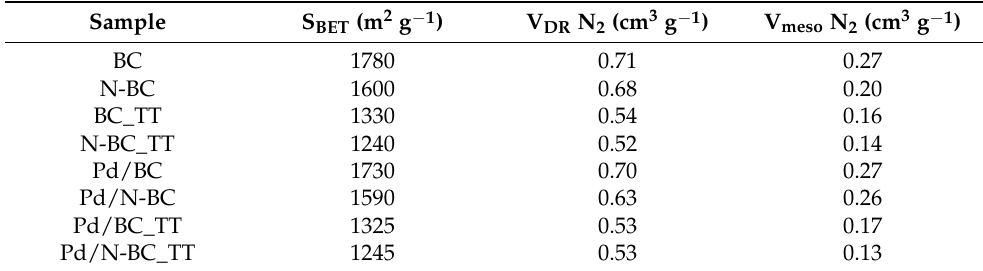
Table 1. Porous texture characterization.